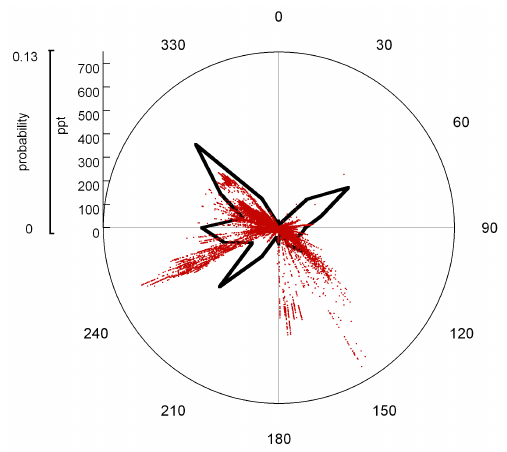
Fig. 6. Wind direction (by origin) plot of NO 3 +N 2 O 5 (hourly mean) with wind direction probability, binned into 20 ◦ regions by origin (black line), during times when BBCEAS measurements were made and an LOD reported during